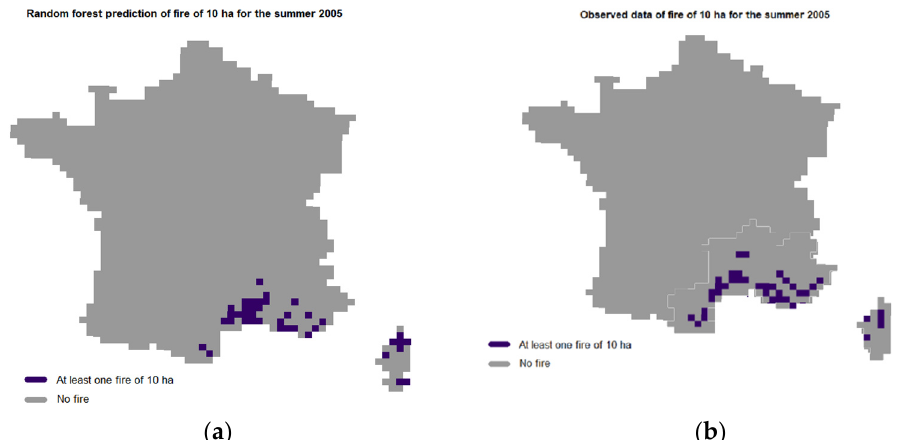
Figure 11. The figure compares ( a ) the modelled prediction of fires of 10 ha for the summer of 2005 using a random forest, and observations from the same year ( b ).